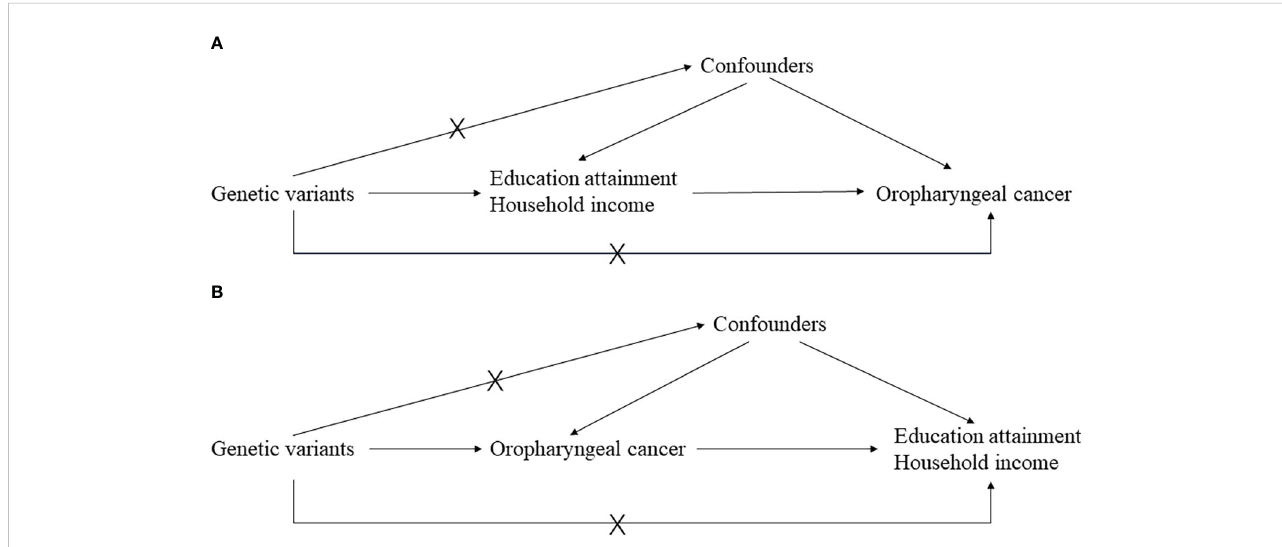
FIGURE 1 The main design of this study. (A) is the basic principal assumptions of the two-sample Mendelian randomization design; (B) is the reverse Mendelian randomization design.